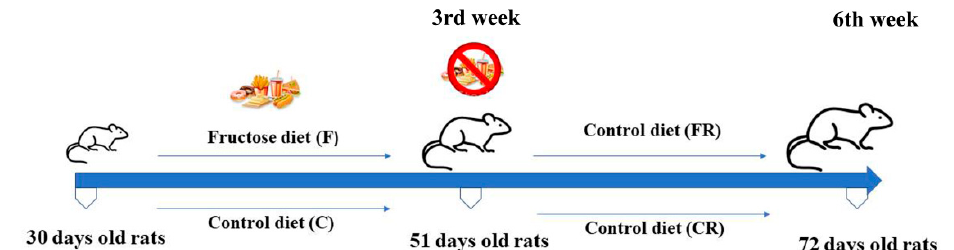
Figure 1. Experimental design.